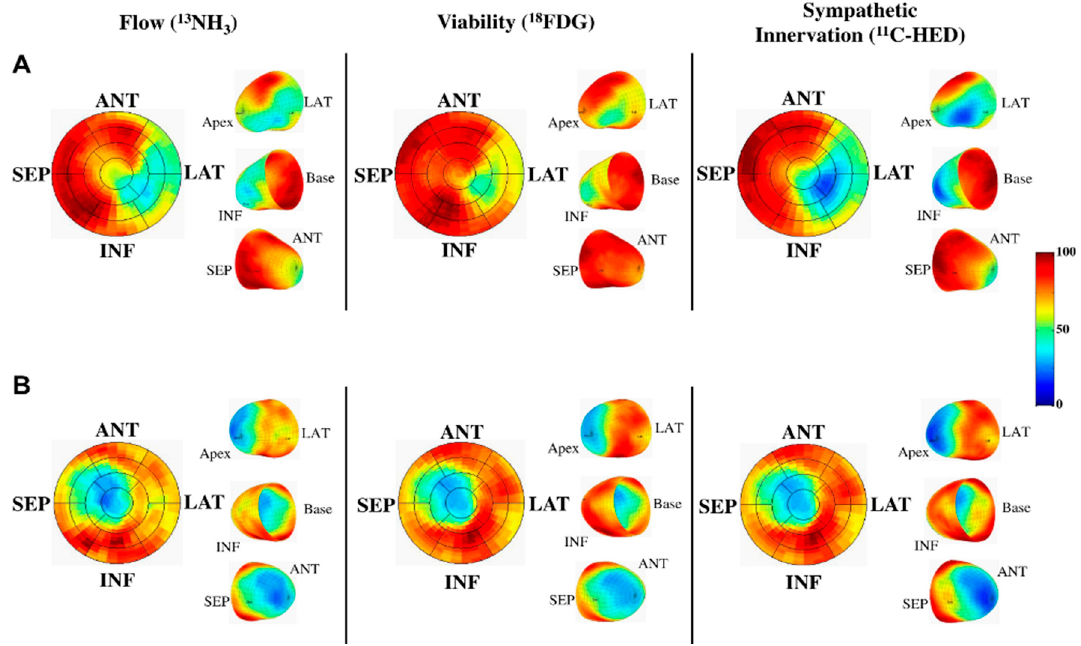
Figure 6. PET imaging of flow, viability and sympathetic innervation in two patients with ischemic cardiomyopathy to predict risk from sudden cardiac arrest (SCA). The subject in ( A ), who developed an SCA, demonstrated a larger volume of sympathetic denervation by 11 C-HED compared to infarct size by 18 F-FDG uptake. There was also reduced perfusion by 13 NH with preserved 18 F-FDG indicating hibernating myocardium. In contrast, ( B ) shows a subject with matched reductions in flow, infarct volume and sympathetic denervation. ANT = anterior; INF = inferior; LAT = lateral; PET = positron emission tomography; SEP = septum. Reproduced from Fallavollita et al., 2014, by permission of J. Am. Coll. Cardiol. [133].